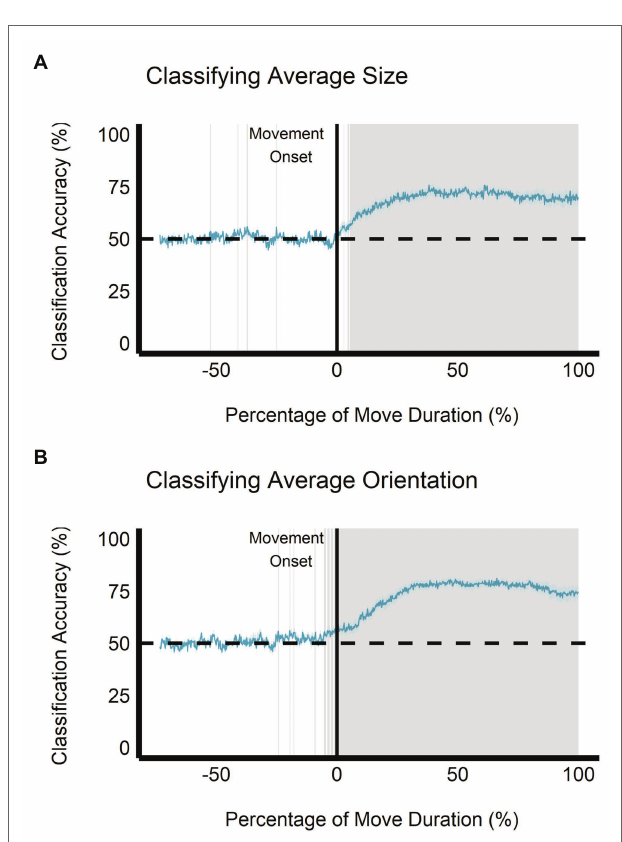
FIGURE 9 | Multivariate results of the perceptual manual-estimation task. Support vector machine (SVM) classification accuracy is plotted for discriminations of (A) average ensemble size (small vs. large) and (B) average ensemble orientation (CW vs. CCW) across the duration of movement. Negative percentage values of movement duration show baseline accuracy values beginning at stimulus onset. The gray shaded area represents timepoints where SVM classification accuracy is significantly different than chance level after correcting for false discovery rate. Gray shaded rectangles = p < 0.05; Light blue region = depicts